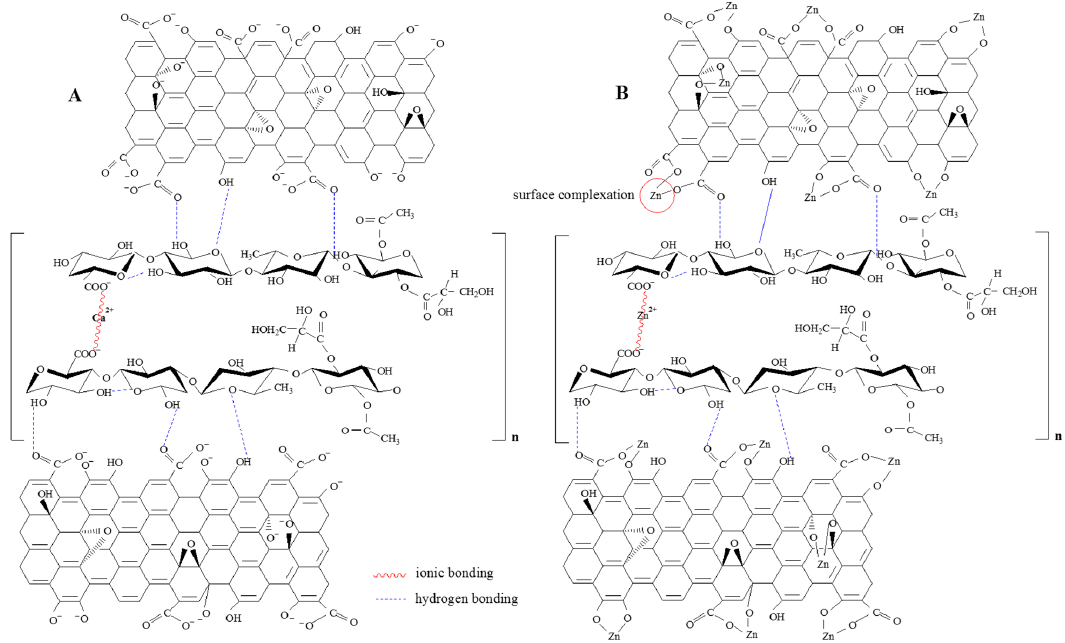
Figure 11. Schematic representation of Zn (II) sorption on GG / GO at pH 6. ( A ): before sorption; ( B ): after